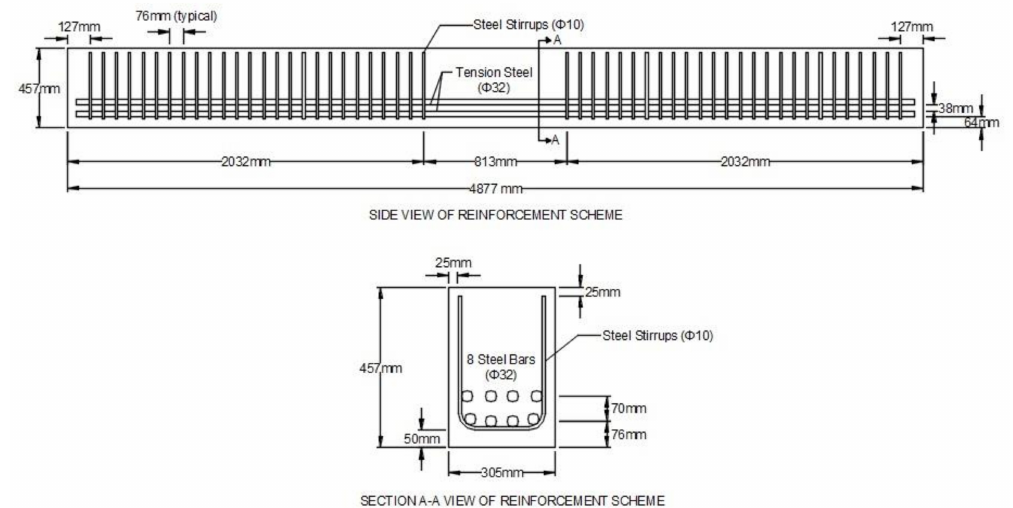
Figure 9. Side (top part of figure) and cross-sectional (bottom part of figure) views of reinforcement scheme for control beam showing longitudinal tension steel ( Φ 32 bars) and steel vertical U-shaped stirrups ( Φ 10 bars).